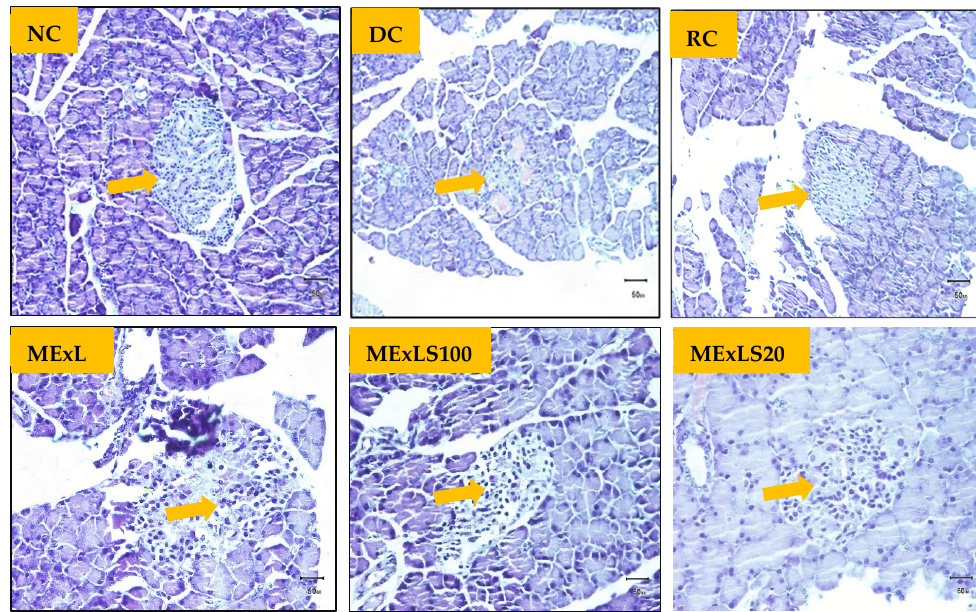
Figure 5. Pancreatic tissue from various experimental animals’ groups is shown in a histopathological image (H & E staining × 125) (microscopic resolution: 10 × 40). The pancreatic islet of Langerhans is depicted by an arrow. These pancreatic slices stained with PAS and counterstained with hematoxylin are exhibited under light microscopy. Table 5. Scoring for the effect of ME X LS on the pancreatic architectures.